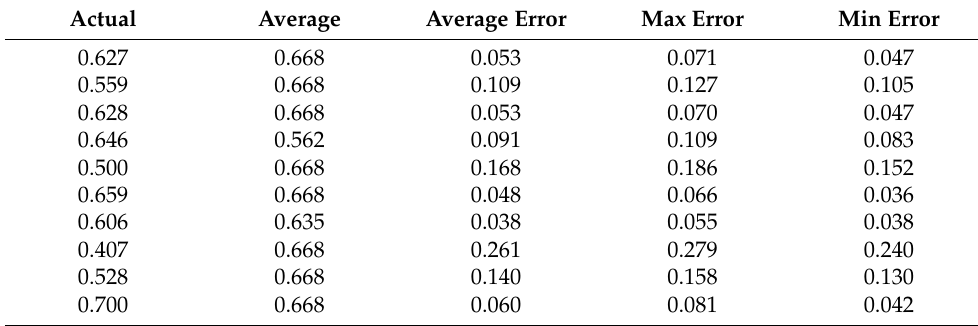
Table A128. Set 2, trials 31–40 data (average actual PR value).